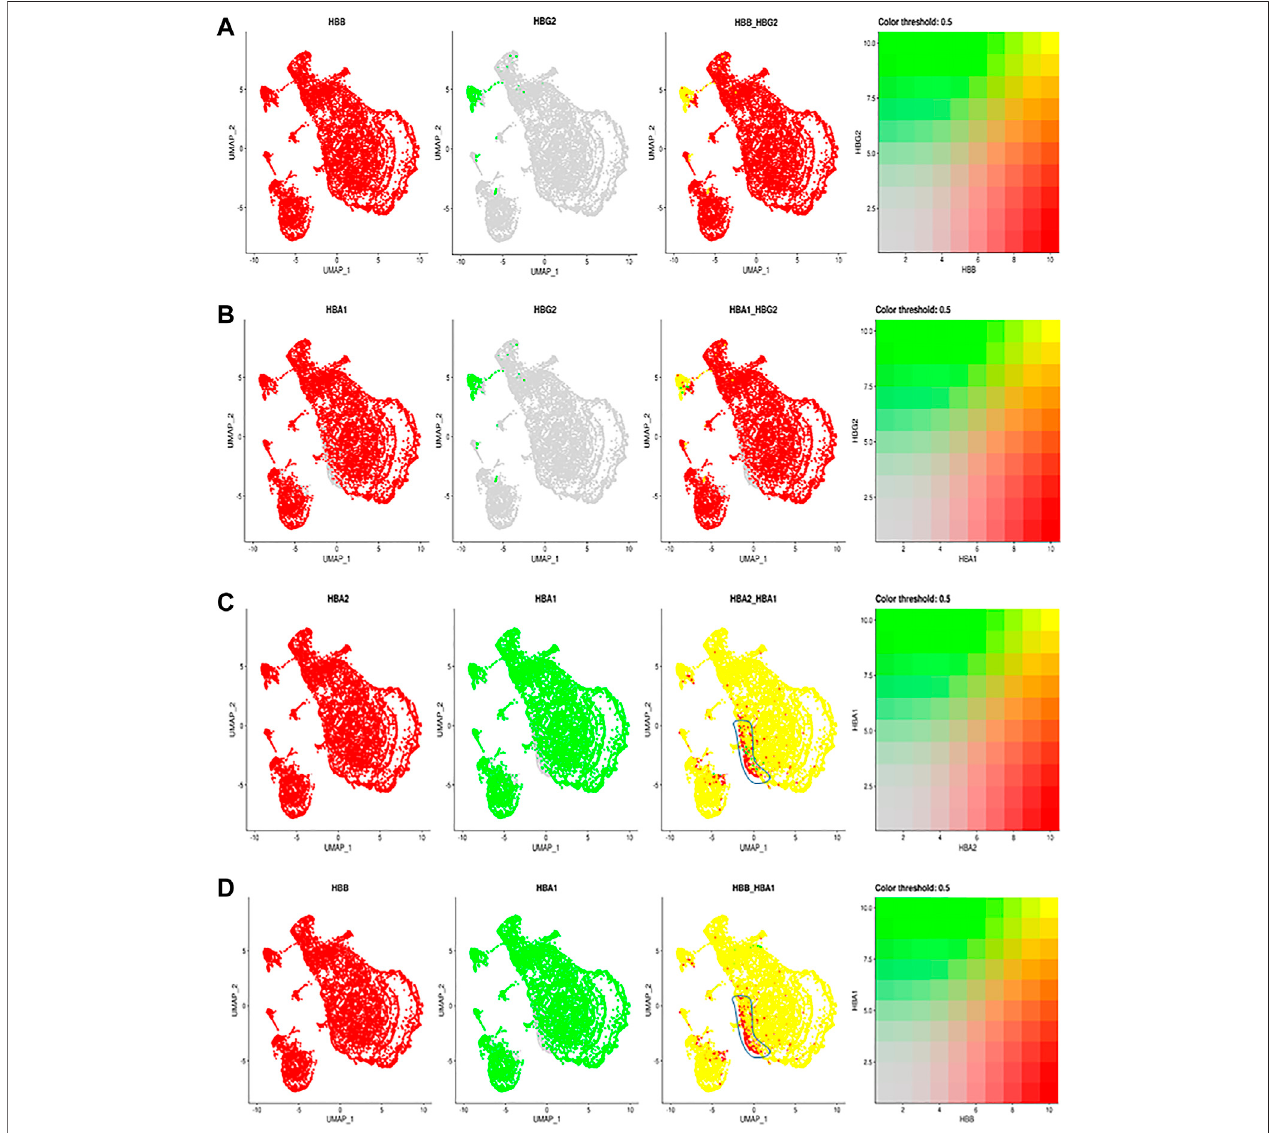
FIGURE 2 | The comparisons and correlations of different hemoglobin genes in the individual RBCs. Pairwise comparison of hemoglobin genes within the overall UMAPprojectionincluding (A) HBBvs.HBG2 (B) HBA1vs.,HBG2 (C) HBA2vs.HBA1and (D) HBBvs.HBA,whereeach geneisassignedacolorredorgreenandthe intersection of expression is yellow, or the absence of expression is re fl ected in the primary gene color (right of each fi gure).